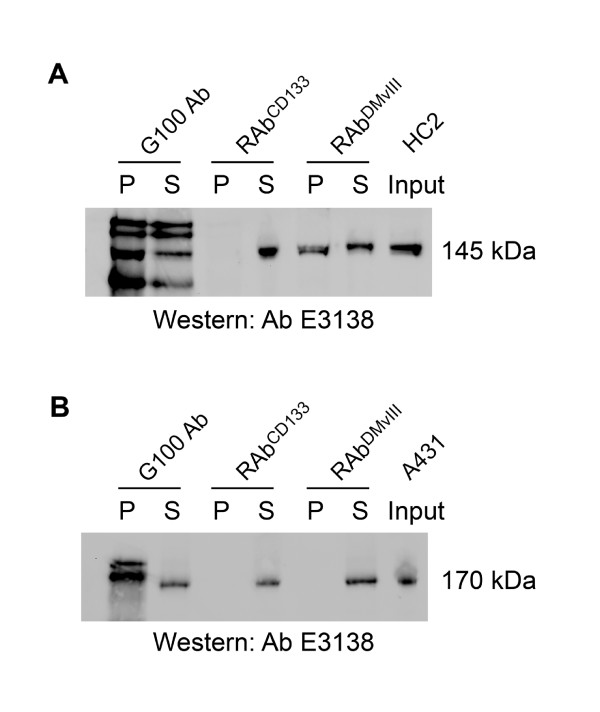
Immunoprecipitation of EGFRvIII by RAbDMvIII. Immunoprecipitation was performed with RAbDMvIII, Monoclonal EGFRvIII antibody and RAbCD133 (negative control for our recombinant antibody) on HC2 and A431 cell lysates. A) HC2 lysates immunoprecipitated by Monoclonal EGFRvIII antibody, RAbDMvIII showed 145 kda band corresponding to EGFRvIII in the pellet whereas 145 kda band is seen in the sup of RAbCD133 when immunoblotted with E3138 antibody from sigma. B) On the other hand A431 cell lysate showed 170 kda protein band corresponding to EGFR in the supernatant of Monoclonal EGFRvIII antibody, RAbDMvII1 and RAbCD133samples.